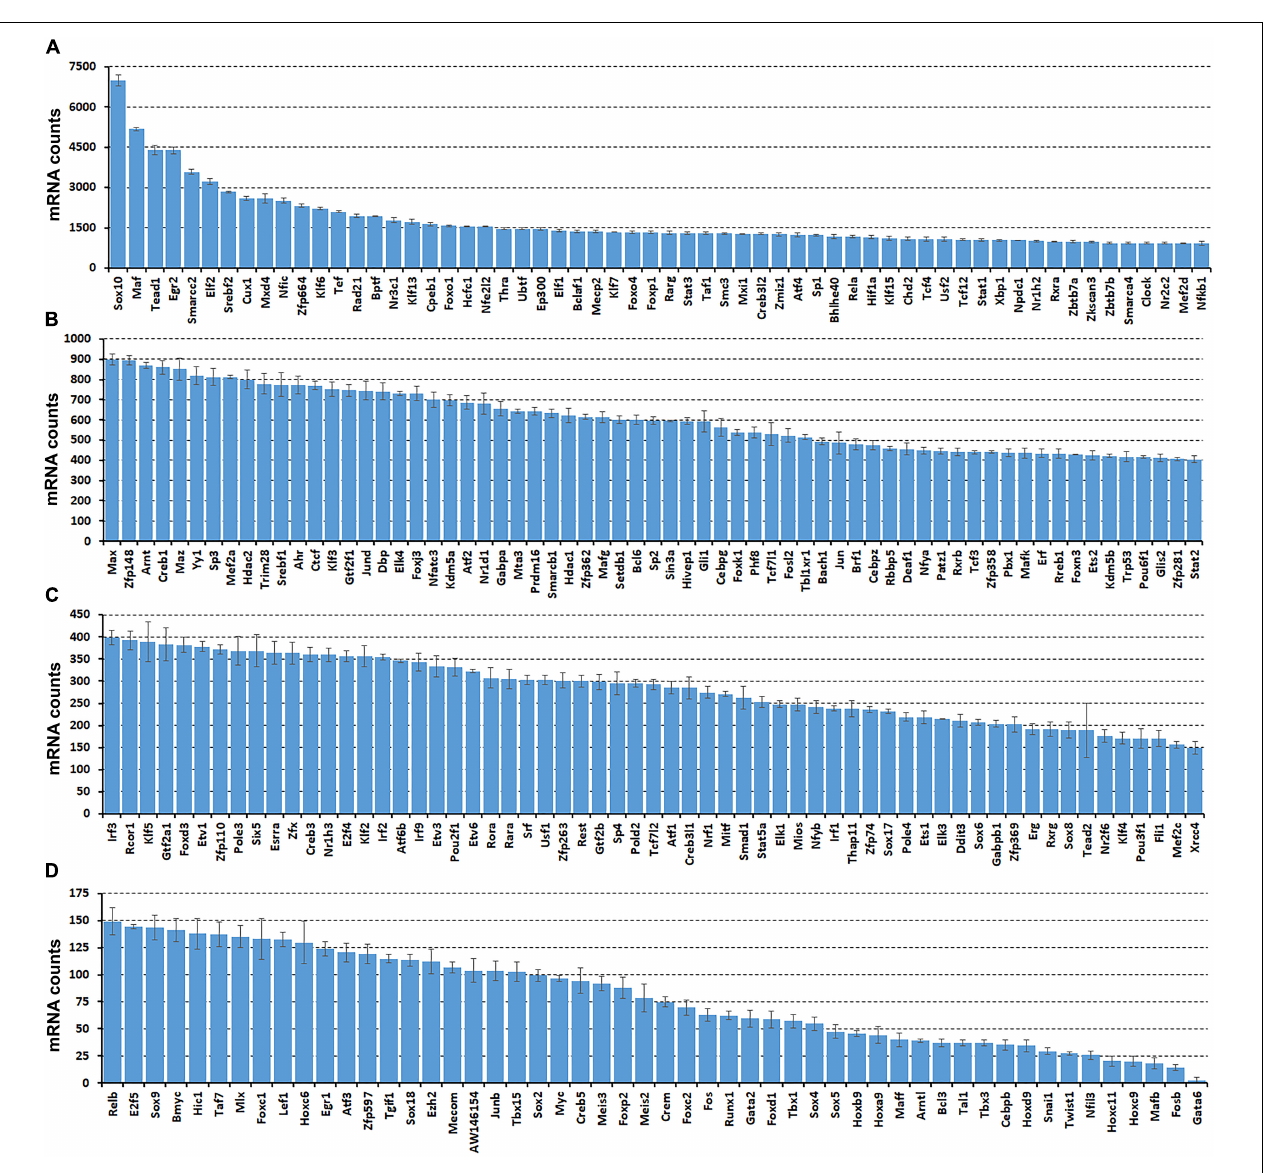
FIGURE 2 | Comparison of normalized messenger RNA (mRNA) counts for the identified 238 TFs in intact mouse sciatic nerve to show their relative expression in mRNA levels. Bulk mRNA sequencing data was analyzed with the data set, GSE108231. (A) Sixty TFs have mRNA count bigger than 900. (B) Sixty-five TFs have mRNA counts ranging from 400 to 900. (C) Sixty-one TFs have mRNA count ranging from 150 to 400. (D) Fifty-two TFs have mRNA count smaller bigger than 150. Normalized mRNA counts are shown as mean ± SEM, n = 3.